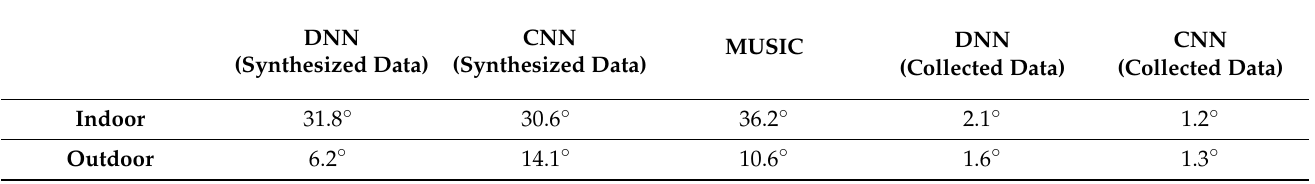
Table 3. A total RMSE of DoA estimation